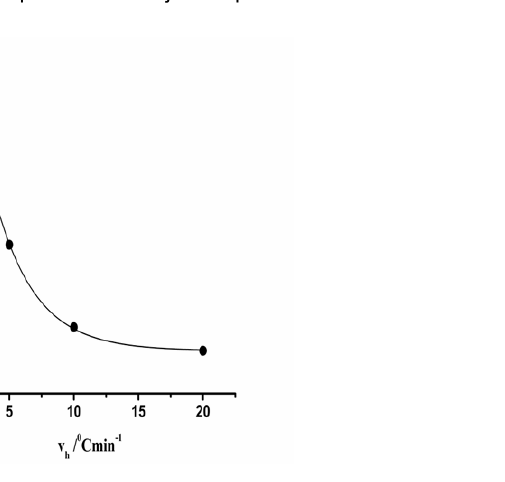
Figure 5 – The exponential relationship between the Weibull scale parameter ( η ) and the heating rate (v h ) (Eq. (13)) for the reduction process of NiO under hydrogen atmosphere Slika 5 – Eksponencijalna veza izme đ u Vejbulovog skalarnog parametra ( η ) i brzine zagrevanja (v h ) (jedna č ina (13)) za proces redukcije NiO pod atmosferom